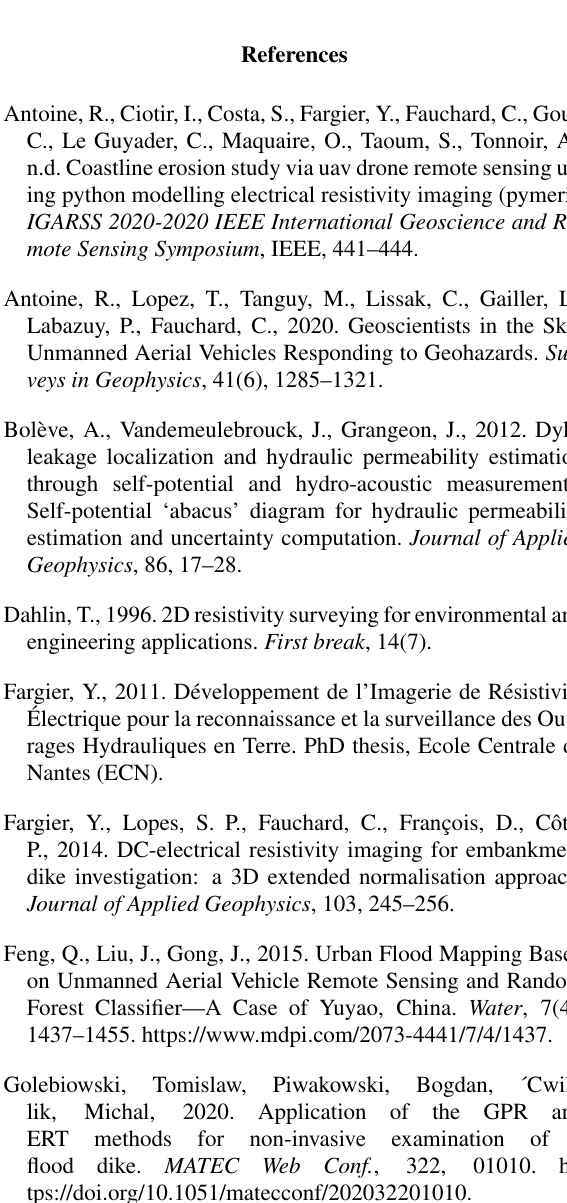
Figure 9. Global view of the combined DTM and longitudinal/transverse ERT profiles on section